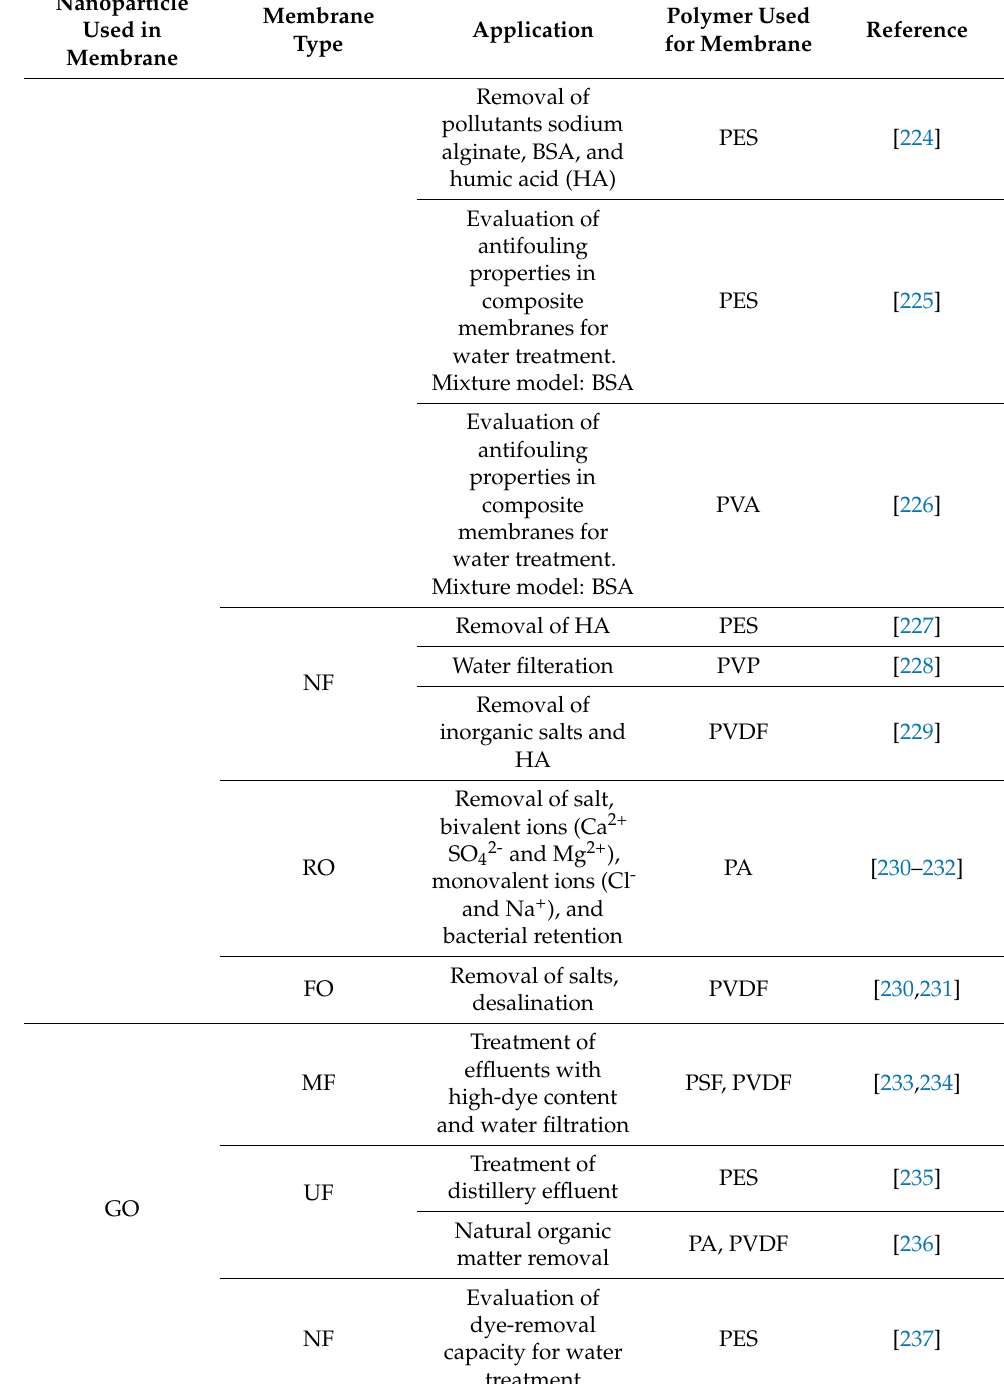
Table 7. Cont. Nanoparticle Used in Membrane